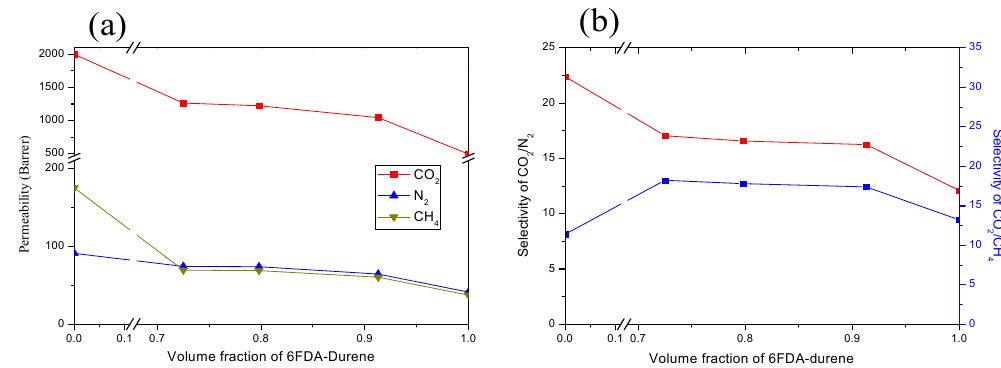
Figure 7. Effect of the 6FDA-durene content on the permeability ( a ) and selectivity ( b ) of the(PIM-PI)x-(6FDA-durene-PI)y copolymer membranes.